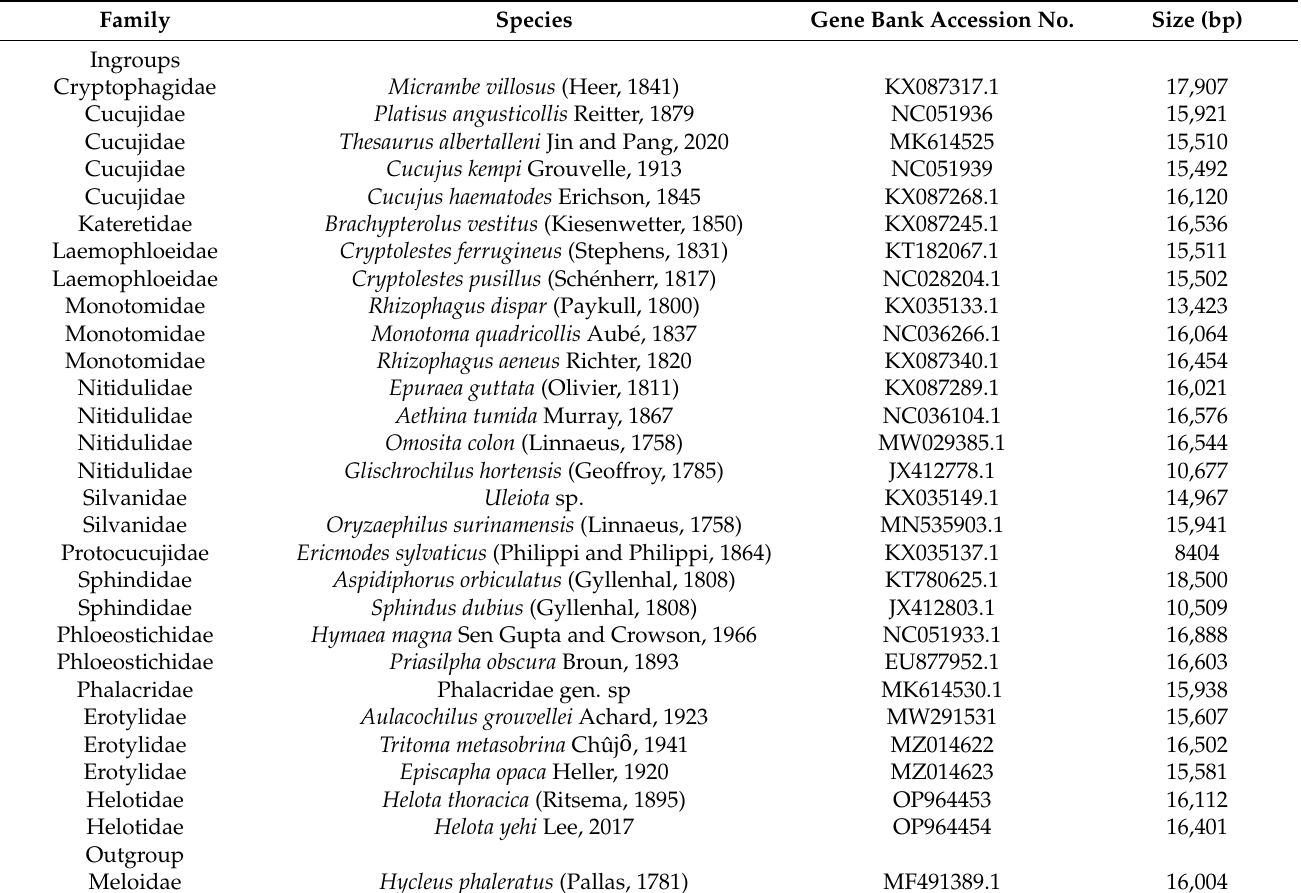
Table 1. List of taxonomic groups used for the phylogenetic analyses in this study.